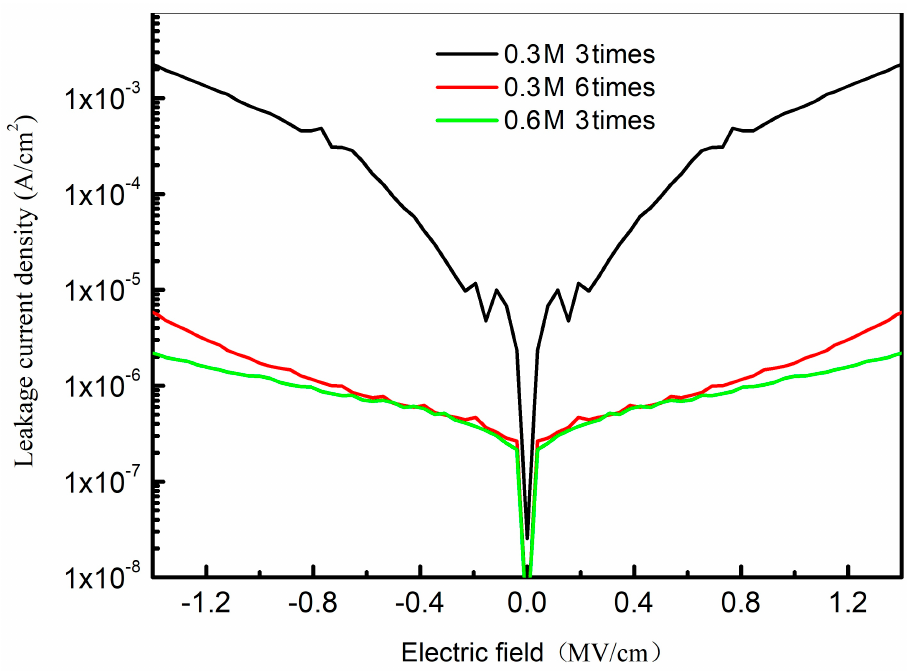
Figure 3. The leakage current density of the ZrO 2 films with altering thicknesses.